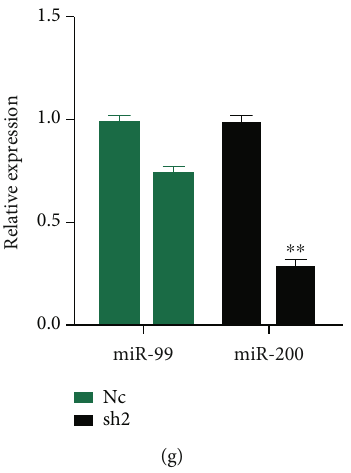
Figure 5: WTAP-dependent m6A demethylation regulates the processing of miR-200 via DGCR8. (a) CLIPdb and starBase2 databases were used to predict the interaction proteins of WTAP. (B) Coimmunoprecipitation of the WTAP-interacting protein DGCR8. A2780 cells were crosslinked before the immunoprecipitation. WTAP gene was tagged by fl ag in advance. Ribonuclease was applied as indicated. Immunoglobulin G antibody was used as negative control for the experiment. (c) Immunoprecipitation of DGCR8, WTAP, and associated RNA from control cells or cells overexpressing WTAP (+ stands for control, ++ represents over expressed WTAP fl ag). Western blot and immunoblot experiments were done using the antibodies as depicted. (d) Downregulated and upregulated miRNAs were analyzed and selected in OC tissues compared to adjacent normal tissues from Gene Expression Omnibus microarray pro fi les (GSE131790, GSE25405, GSE119055, and GSE135469). (e) Gene-wide expression pro fi ling chip was fabricated in A2780-Nc and A2780- sh2 cells to screen di ff erentially expressed miRNAs after WTAP knockdown. (f) Pri-miR-99 and pri-miR-200 were detected by RT-qPCR upon WTAP silencing in A2780 cells. (g) MiR-99 and miR-200 expressions were detected by RT-qPCR upon WTAP silencing in A2780 cells. Annotation: RNase = ribonuclease; IP = immunoprecipitation; IgG = immunoglobulin G; oe =